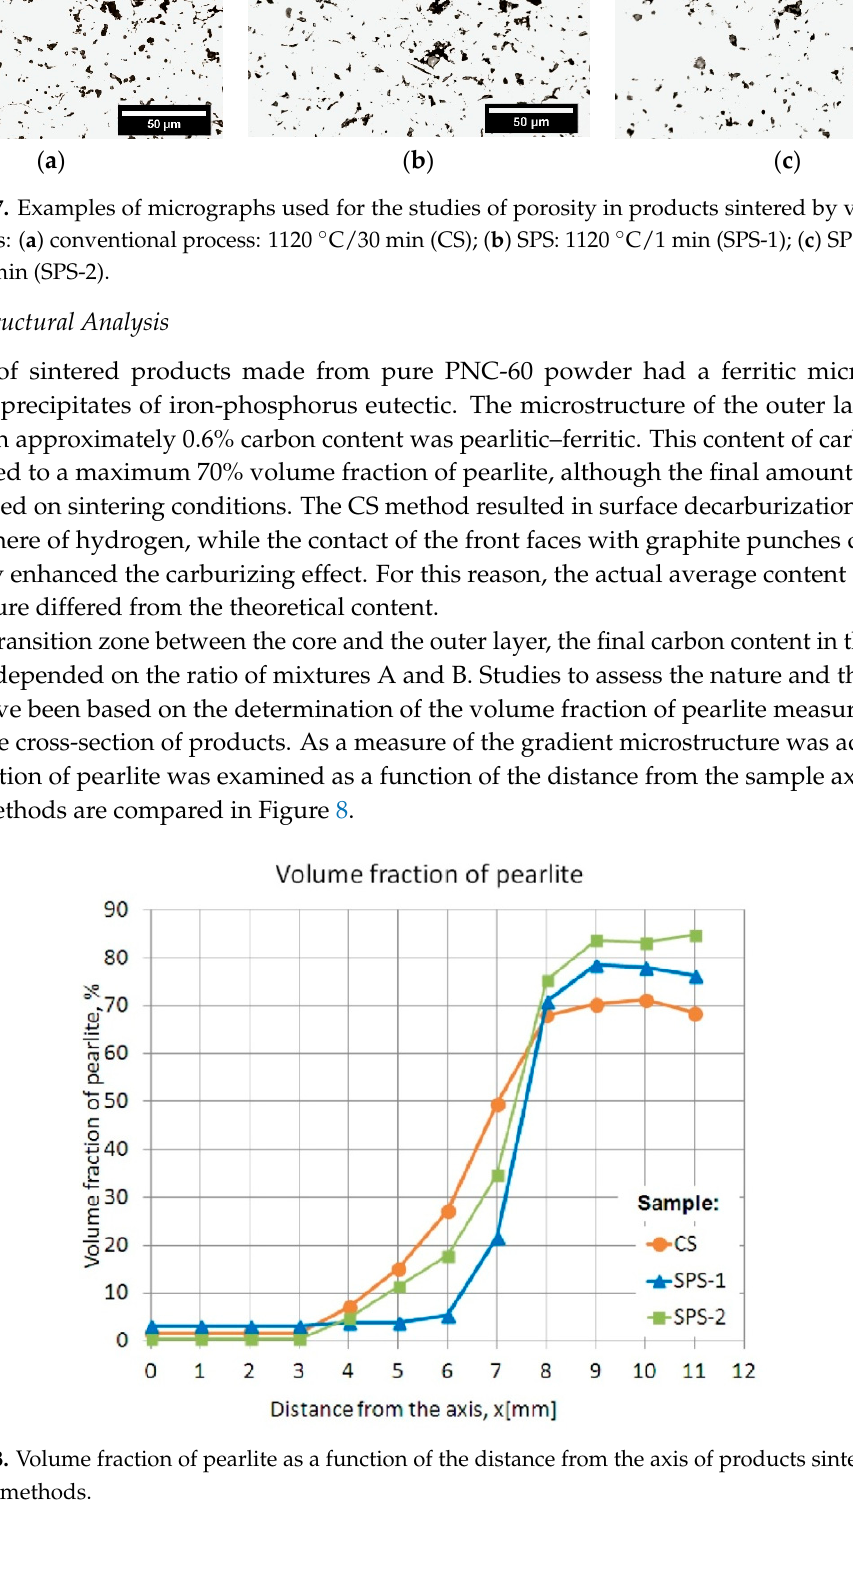
Table 5. Parameters of porosity. Sample ( c ) Figure 6. Comparison of porosity structure in products sintered by various methods: ( a ) the distribution of roundness ( f r ); ( b ) the distribution of aspect ratio ( f ar ); and ( c ) the distribution of the size of pores ( a ). Examples of the micrographs that were used for the studies of porosity in products sintered by various methods are shown in Figure 7. The final size and shape of voids depend on the time and temperature of the heat treatment applied to samples. The structure of porosity after CS (Figure 7a) is characteristic of iron powder products with a relative density of ρ w ≅ 0.9 . Small voids have a nearly Figure 7. Examples of micrographs used for the studies of porosity in products sintered by various methods: ( a ) conventional process: 1120 °C/30 min (CS); ( b ) SPS: 1120 °C/1 min (SPS ‐ 1); ( c ) SPS: 1050 °C/10 min (SPS ‐ 2).